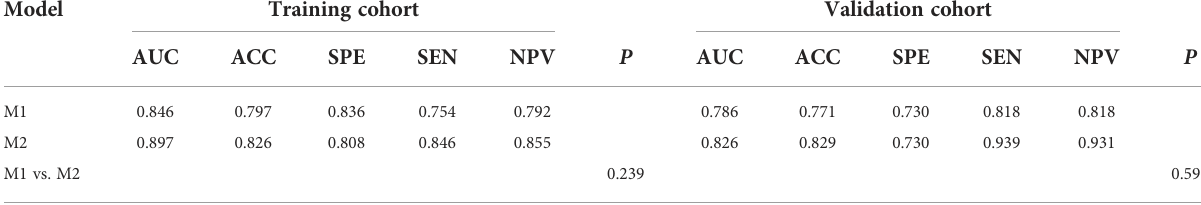
Table 3 Comparisons of prediction performance of mammography and MRI.